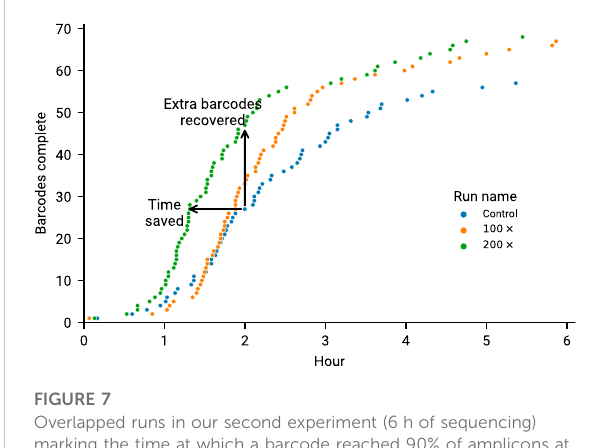
FIGURE 7 Overlapped runs in our second experiment (6 h of sequencing) marking the time at which a barcode reached 90% of amplicons at 20×.Itisworthnotingtheincreasedperformanceof200×islikelydue to the increased yield, as this was the fi rst run to go on. Time saved is considered to be points for a run that are shifted left of their equivalents on the y -axis. Any points above the Control run (at the same time) are considered as extra barcodes